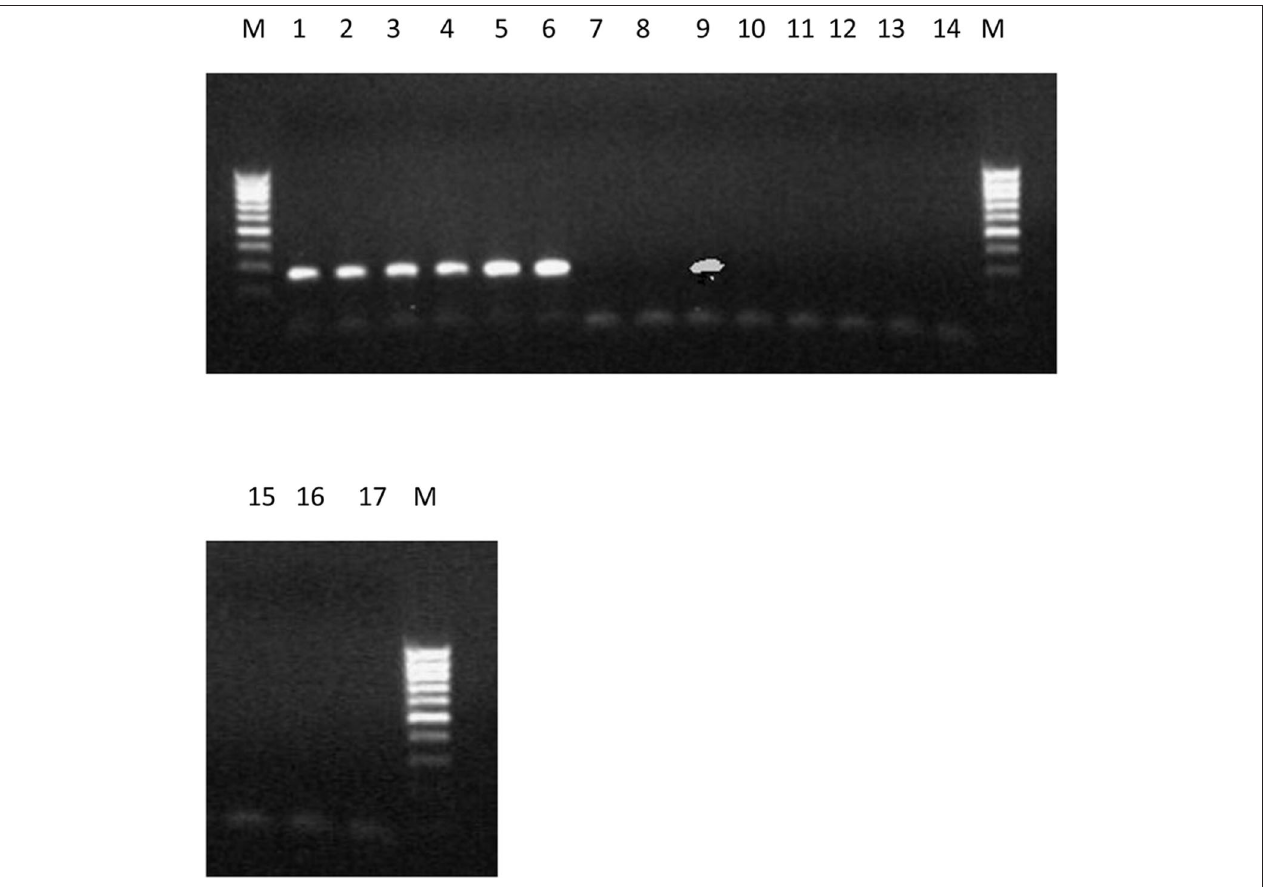
FIGURE 8 | PCR products produced using primer set ORX-F1 and ORX-R1 and DNA from 17 strains of F. oxysporum f.sp. elaeidis from different African countries. The presence or absence of ORX1 effector genes indicates virulence. Lane 1-6(4), CRT, EK1B, PWIIM, PW3M, and PW3A. Lane 7-8(1, 13); lane 9 (MAT10B); lane 10-17(PU4APU, MAT14B, MAT9B, 622, PWA, PW11A, PW49A, and